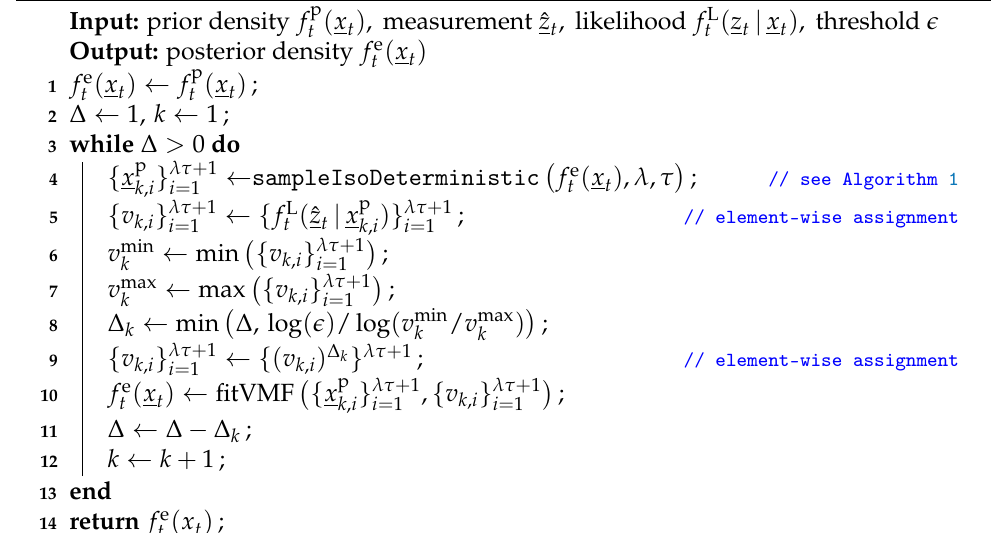
Algorithm 2: Isotropic Progressive